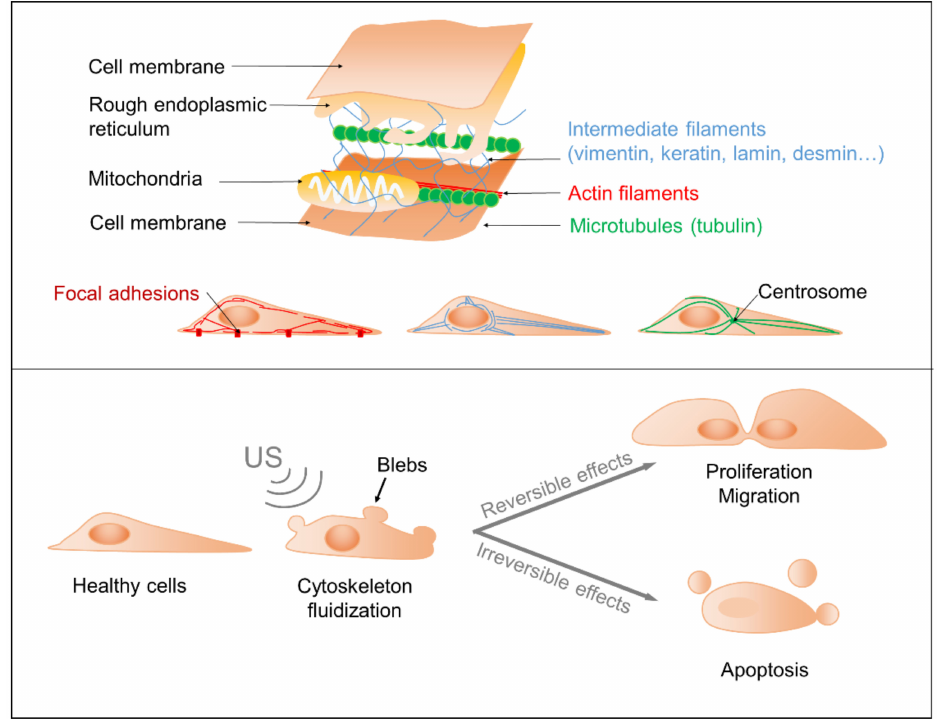
Figure 3. Cytoskeleton and main impacts from US exposure. Top: Schematic outcomes of US on cellular cytoskeleton, proliferation and migration. Bottom: Schematic visualization of the cytoskeleton components. Focal adhesions are integrin-containing multi-protein structures binding actin filaments to the extracellular